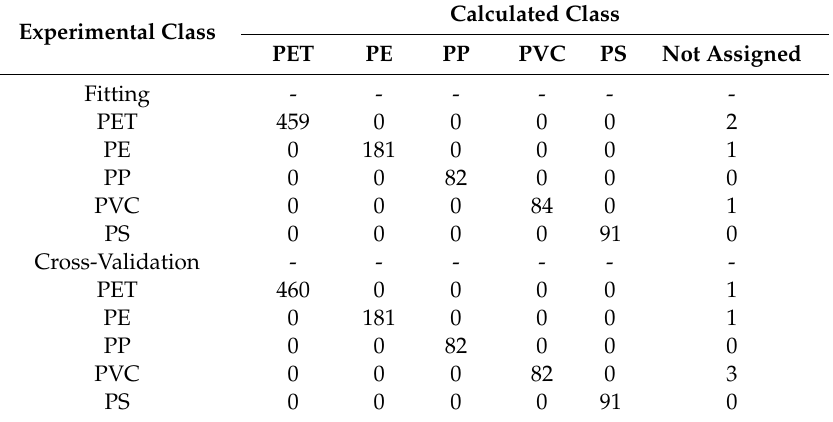
Table 1. Confusion matrices obtained from the PLS-DA model, both in fitting and in cross-validation (based on Venetian blinds with 10 groups). The “Not Assigned” column contains samples which were not assigned to any of the considered classes.